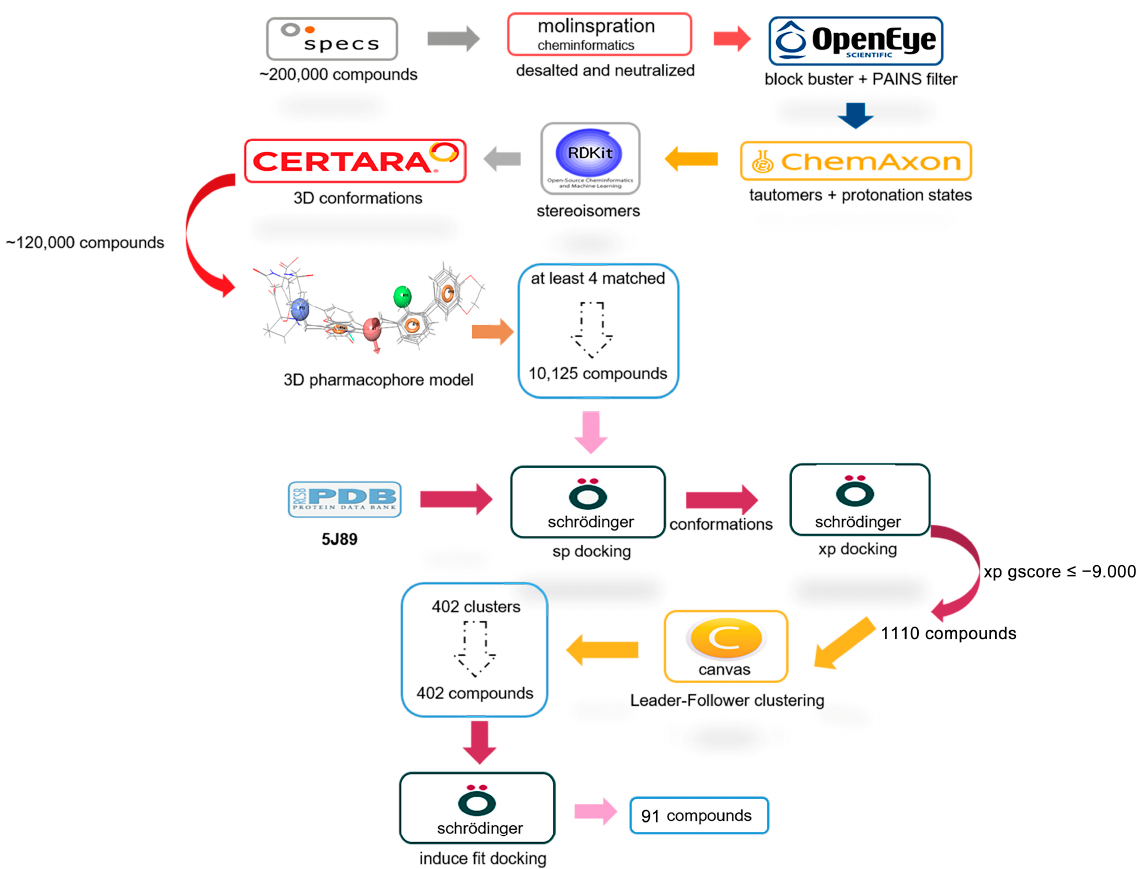
Figure 1. The flowchart for the structure-based virtual screening.